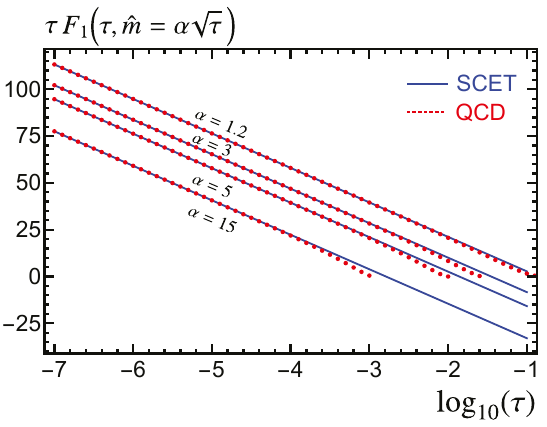
Figure 6 . Comparison of the O ( (cid:11) s ) correction to the di(cid:11)erential cross sections in QCD [ F QCD ( (cid:28); ^ m )] and SCET [ F SCET ( (cid:28); ^ m )]. We enforce the SCET power counting by scaling the 1 V p reduced mass as ^ m = (cid:11) (cid:28) , with (cid:11) = O (1). Solid blue lines show SCET analytic results, while red dots correspond to QCD numerical predictions obtained from the computations in ref. [36]. The numerical values of (cid:11) are shown in the